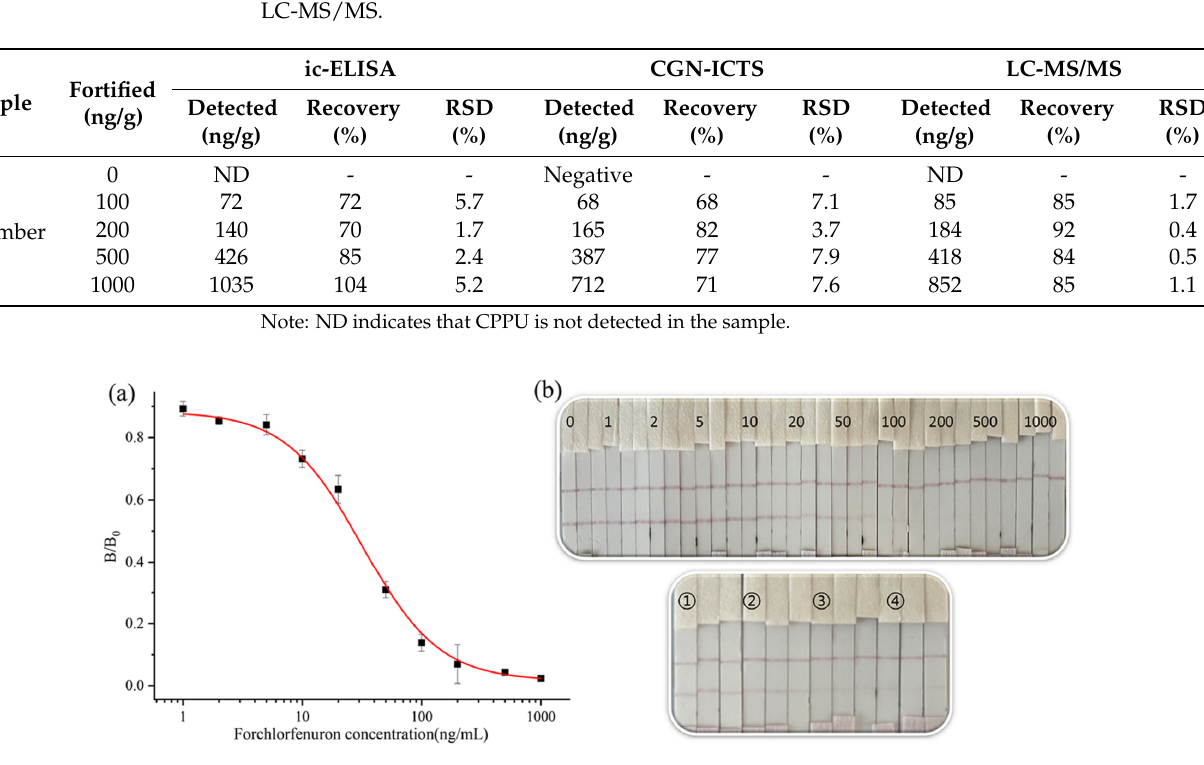
Figure 6. ( a ) CGN-ICTS curve of CPPU in cucumber samples. ( b ) The strip image results for CPPU (0, 1, 2, 5, 10, 20, 50, 100, 200, 500, and 1000 represent CPPU standard concentrations of 0, 1, 2, 5, 10, 20, 50, 100, 200, 500, and 1000 ng/mL, respectively). Analysis of samples by ICTS. Detection of CPPU in cucumber ( ①②③④ represent CPPU concentrations of 100, 200, 500, and 1000 ng/g, respec- tively). Table 4. Average recoveries of CPPU in cucumber samples measured by ic-ELISA, CGN-ICTS, and LC ‒ MS/MS.